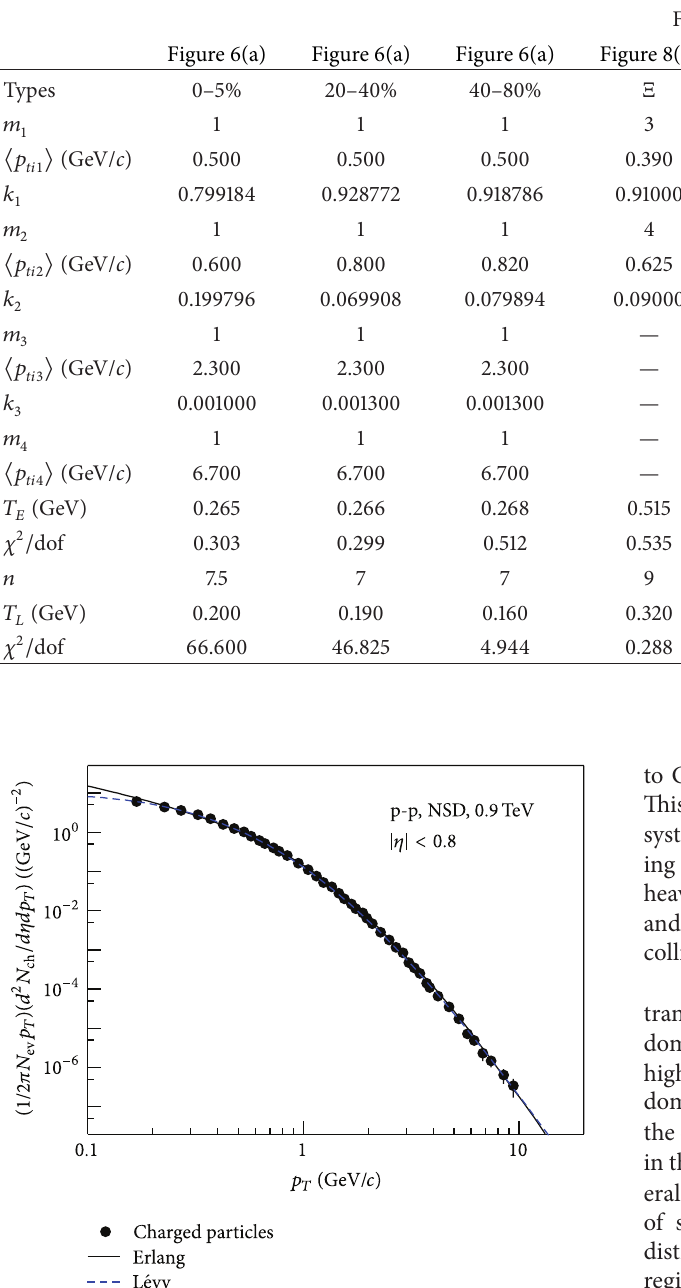
Figure 10: The 𝑝 𝑇 spectrum of charged particles produced in NSD p-p collisions at 0.9 TeV. The symbols represent experimental data measured by the ALICE Collaboration [19]. The solid and dashed curves represent results of the multicomponent Erlang distribution and the L´evy distribution,